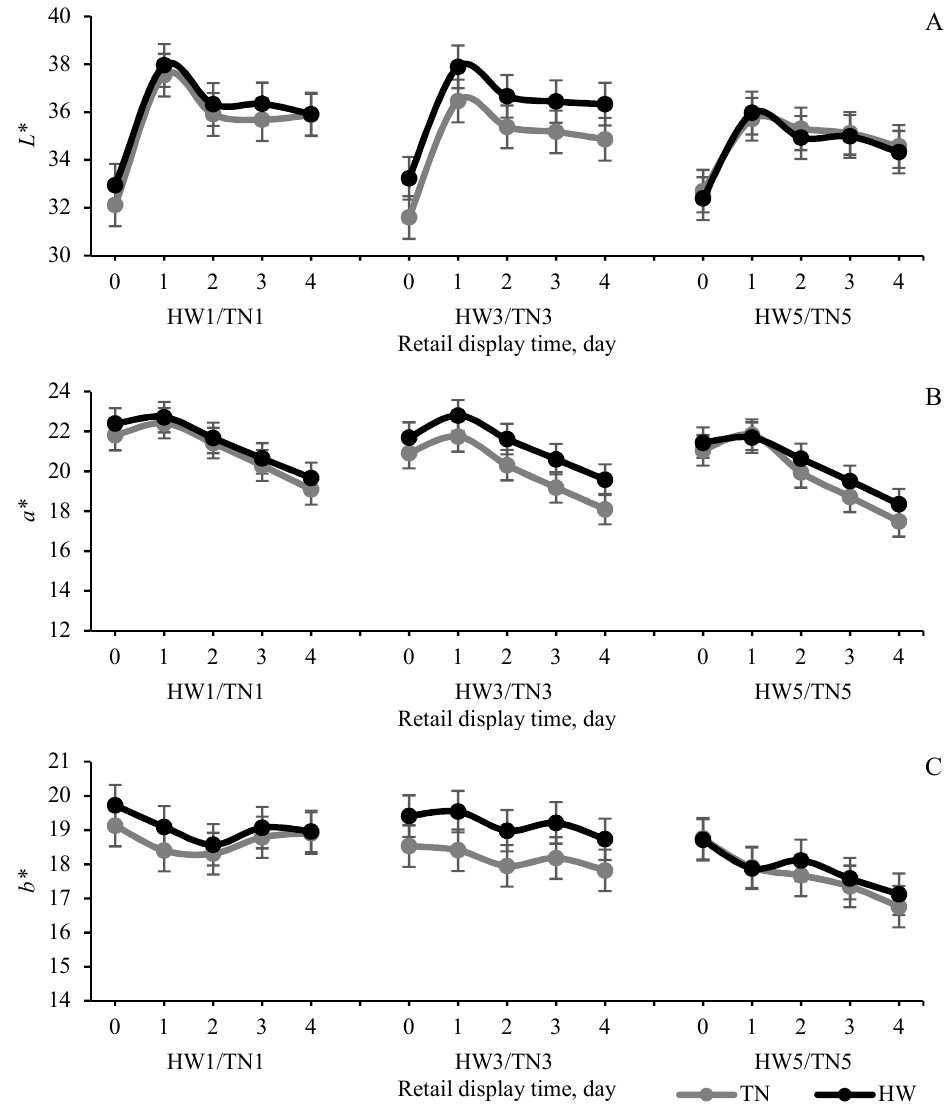
Figure 4. The effect of temperature (thermoneutral, TN vs. heatwaves, HW) and heat exposure duration (1 vs. 3 vs. 5 days) on lightness ( L *), redness ( a *), yellowness ( b *) of longissimus thoracis et lumborum muscle in 4 days’ overwrap retail display: values are mean ± SED. HW/TN1–5 = 1 to 5 days HW/TN groups ( n = 12 per group); lightness ( L *; temp. p = 0.24; day p = 0.19; temp. × day p = 0.43); redness ( a *; temp. p = 0.046; day p = 0.054; temp. × day p = 0.68); Yellowness ( b *: temp. p = 0.046; day p = 0.001; temp. × day p = 0.68). ( A ) lightness ( L *); ( B ) redness ( a *); ( C ) yellowness ( b